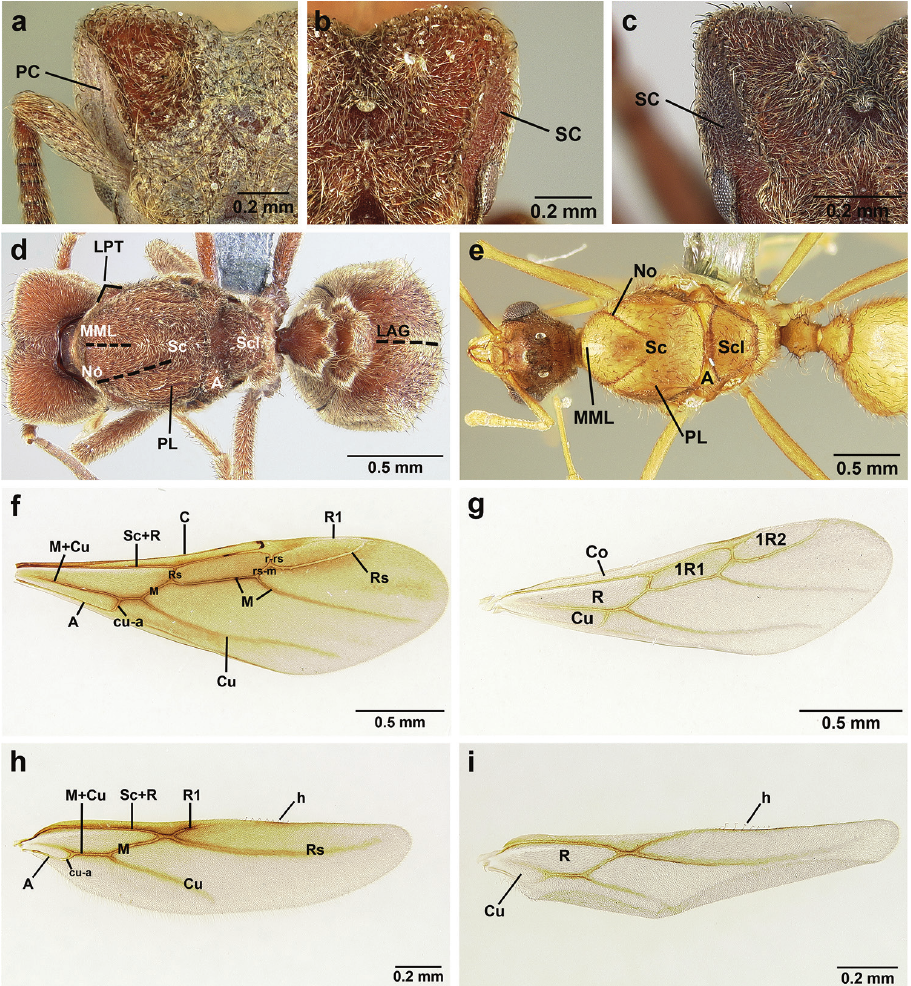
Figure 8. Queen and male morphology. a S. maravalhas queen head, full-face view, preocular carina b S. parvulus queen head, full-face view, supraocular carina; c S. bondari queen head, full-face view, supraocular carina d queen, dorsal view; e male, dorsal view f queen forewing, veins indicated h queen hindwing, veins indicated g male forewing, cells indicated; i male hindwing, cells indicated. PC Preocular carina SC supraocular carinae MML median mesoscutal line No notaulus LPT lateral pronotal tubercle PL parapsidal line A axilla Sc scutum Scl scutellum LAG longitudinal anteromedian groove h hamuli; wing veins ( f, h ): C costa; Sc+R subcosta+radius M media Cu cubitus M+Cu media-cubitus A anal vein cu-a cubitus-anal Rs radial sector R1 radius; wing cells ( g, i ): Co costal; R radial Cu cubital 1R1 first radial 1 1R2 first radial